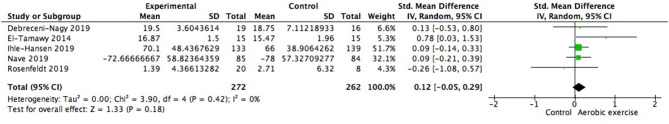
Meta-analysis of effect of aerobic training on cognitive processing speed.